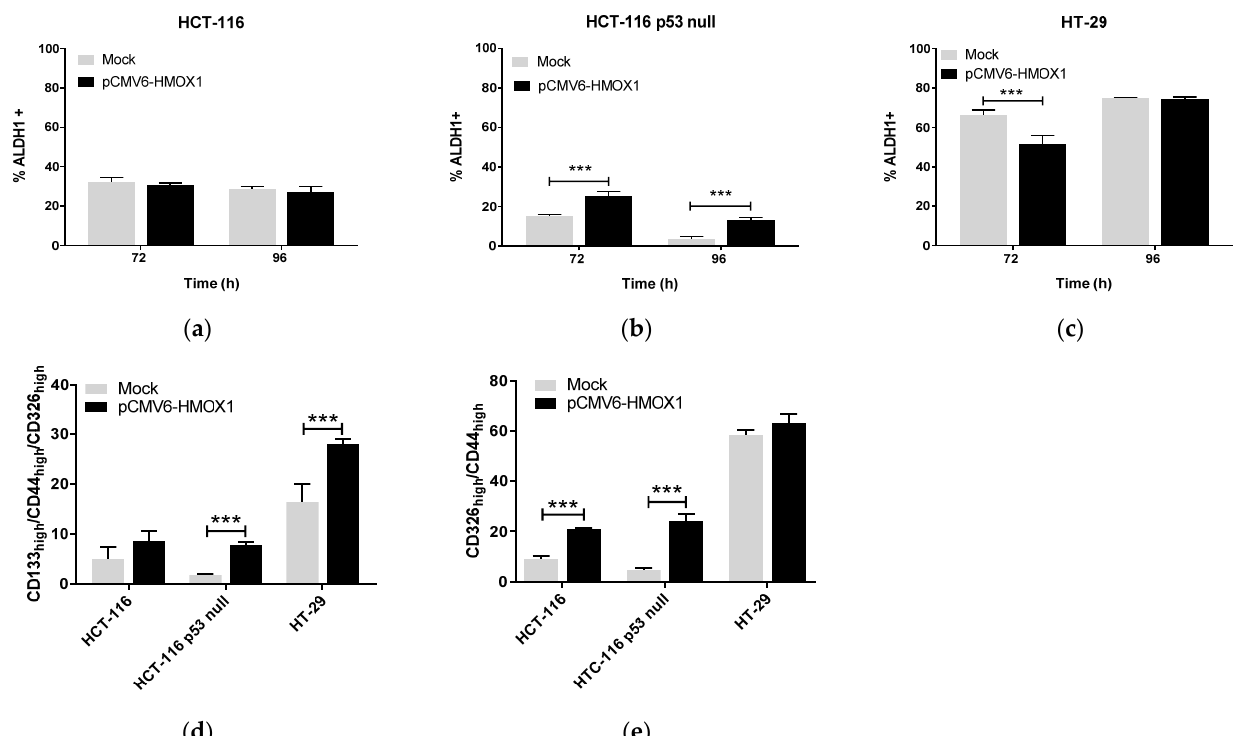
Figure 6. Blockade of endothelin-1 receptors eliminates the HO-1-induced stemness only in p53 wild-type CRC cells. Cells were pCMV6- HMOX1 or mock transfected, treated with 10 μ M bosentan 24 h after, collected at 72 and 96 h after transfection, and used to characterize the percentage of ALDH1+ cells by flow cytometry in the TP of ( a ) HCT-116, ( b ) HCT-116 p53 null, and ( c ) HT-29 CRC cells. In other experiments, cells were collected at 96 h after pCMV6- HMOX1 or empty vector (mock) transfections and used to quantify, in the TP, ( d ) the percentage of CD133 high /CD44 high /CD326 high and ( e ) CD44 high /CD326 high cells. Data represent the mean ± SD of two experiments performed in duplicate. ***, p < 0.001.